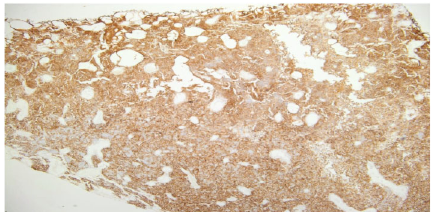
Figure 3: Malignant cells showing high positivity for CD56 marker on immunohistochemistry.